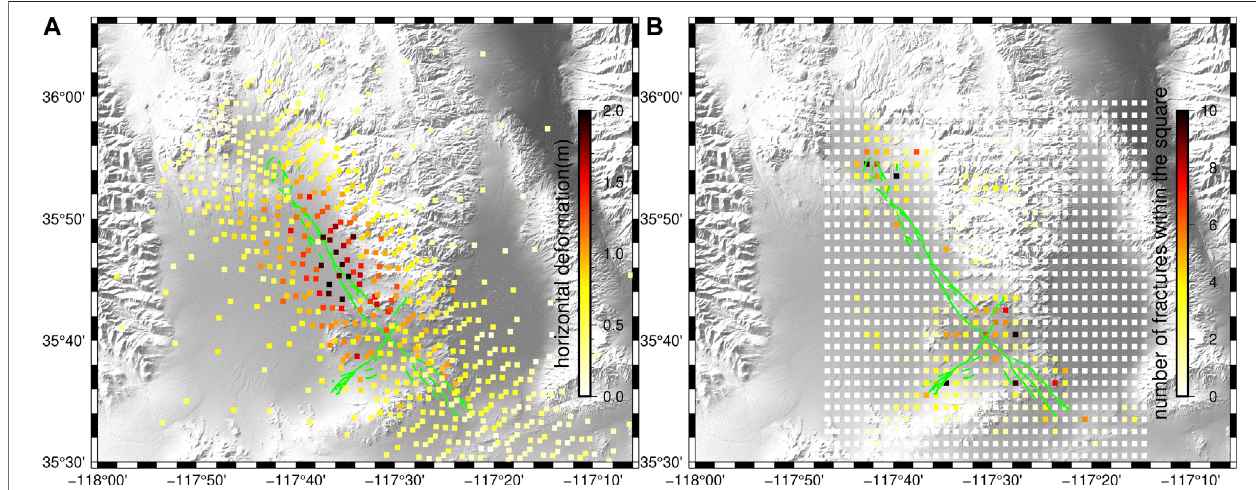
FIGURE4| Magnitudesofhorizontalcoseismicdisplacementsandfracturedensitiesintheepicenterarea. (A) Coloredsquaresrepresentmagnitudesofhorizontal displacements based on the patches for deriving the 3D coseismic displacement fi eld. (B) Colored squares indicate the fracture density calculated on 1.8-by-1.8 km grids. The green line shows the surface ruptures of the 2019 Ridgecrest sequence (Brandenberg et al., 2019).